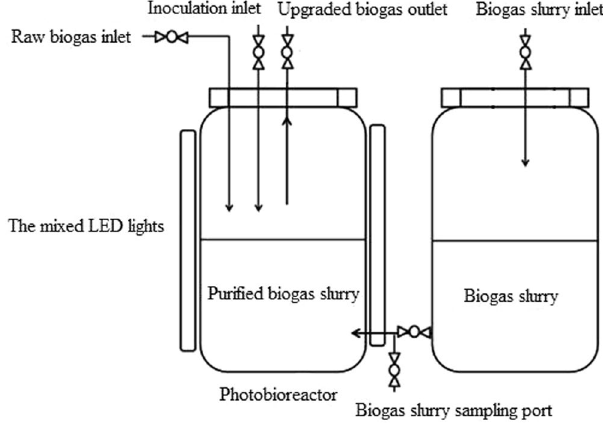
Figure 5. Schematic of the photobioreactor experimental setup.